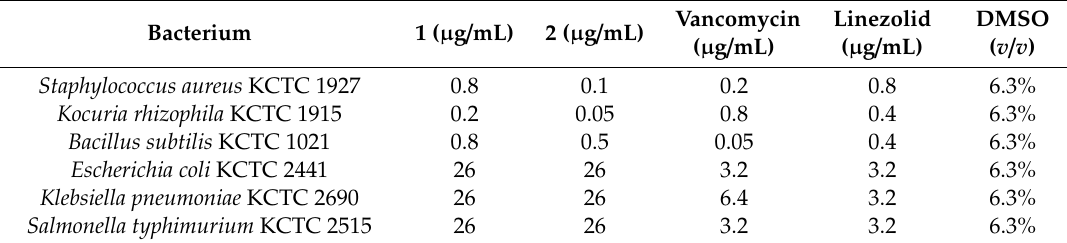
Table 2. Antibacterial activities (minimum inhibitory concentration (MIC)) of compounds 1 and 2